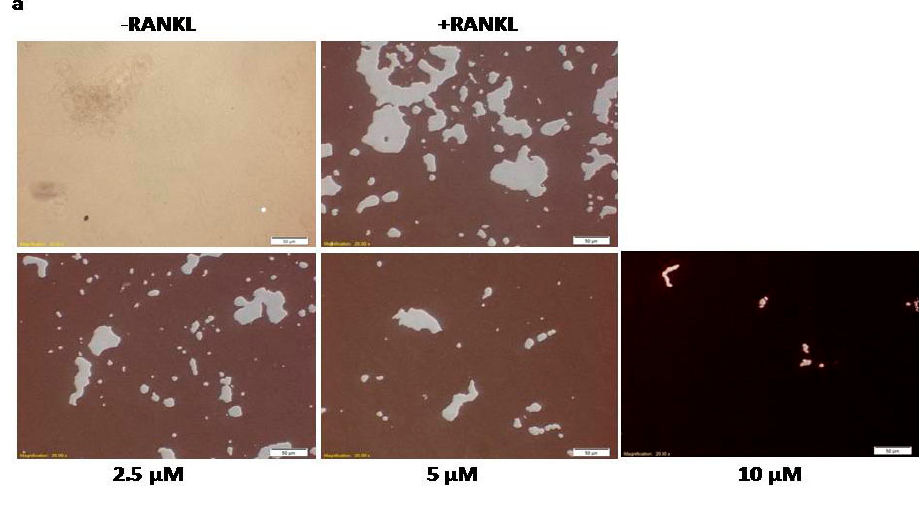
Figure 2. Cont. Figure 2. Cont.